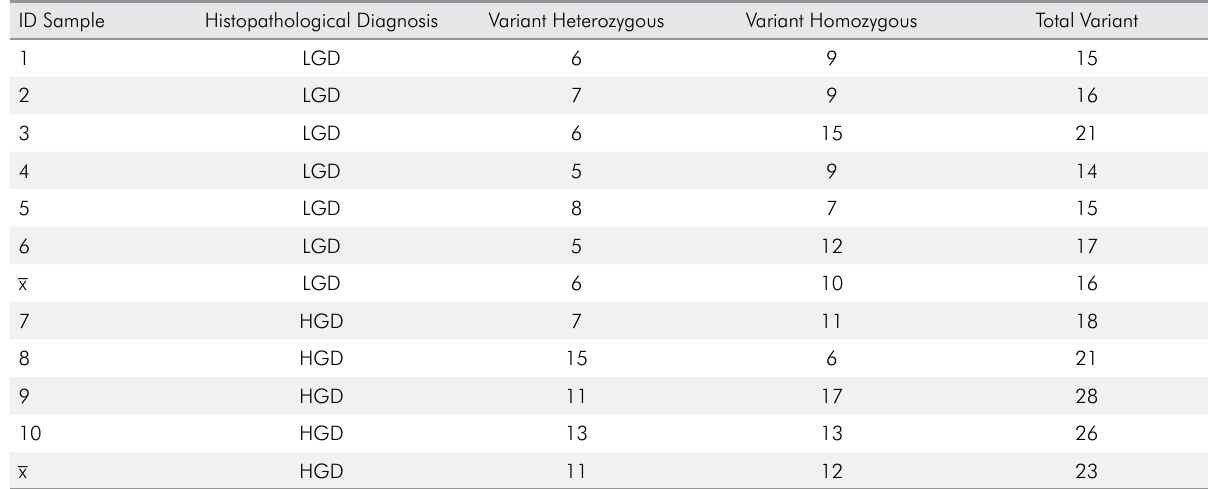
Table 2. Total variants classified according to the Ensembl variant effect predictor as high impact (n = 41) per sample. ID